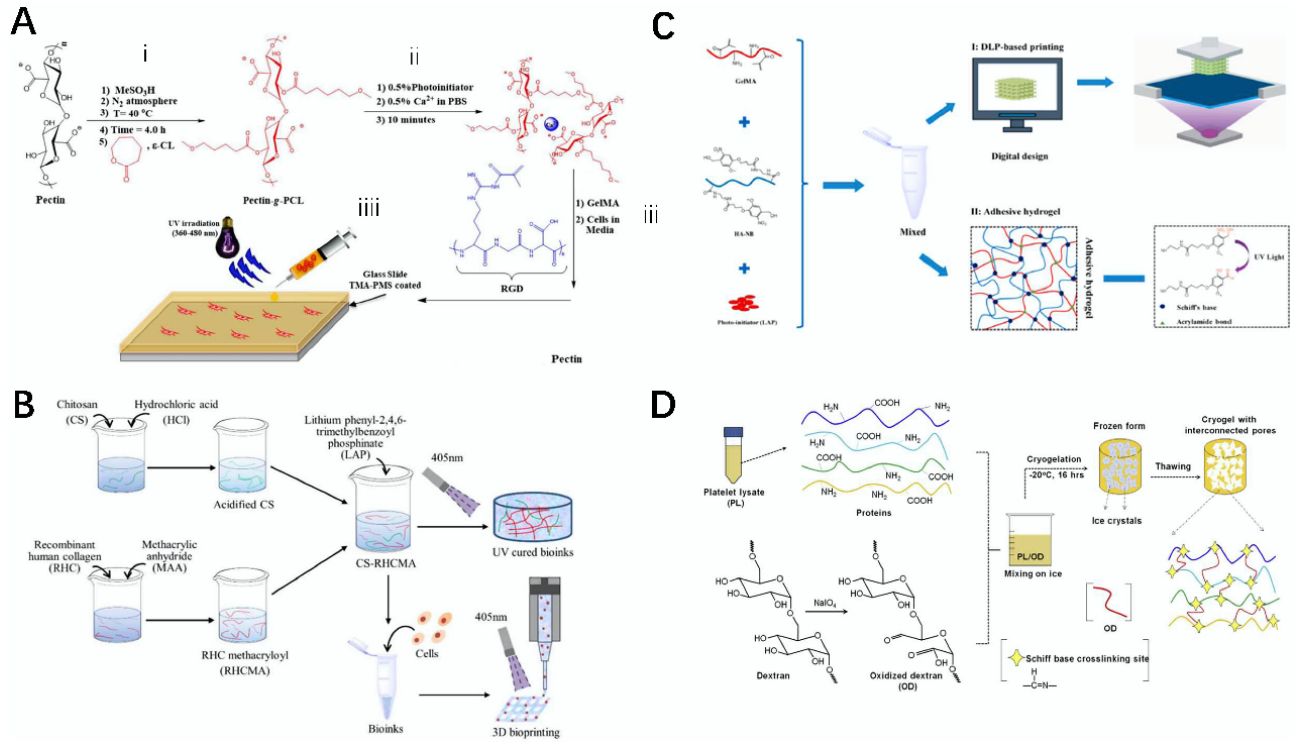
Figure 8. Schematic diagram of hydrogels, bio-scaffolds, and bio-inks prepared from related natural materials and used for 3D printing. ( A ) Schematic diagram of the preparation of GelMA/pectin-g- PCL hydrogels [143]. ( B ) Preparation of CS–RHCMA bio-ink and its use for 3D printing [144]. ( C ) Schematic diagram of the preparation of 3D printed GelMA/HA-NB/LAP hydrogel [145]. ( D ) Sche- matic diagram of the preparation of PO/OD bio-scaffold [146].